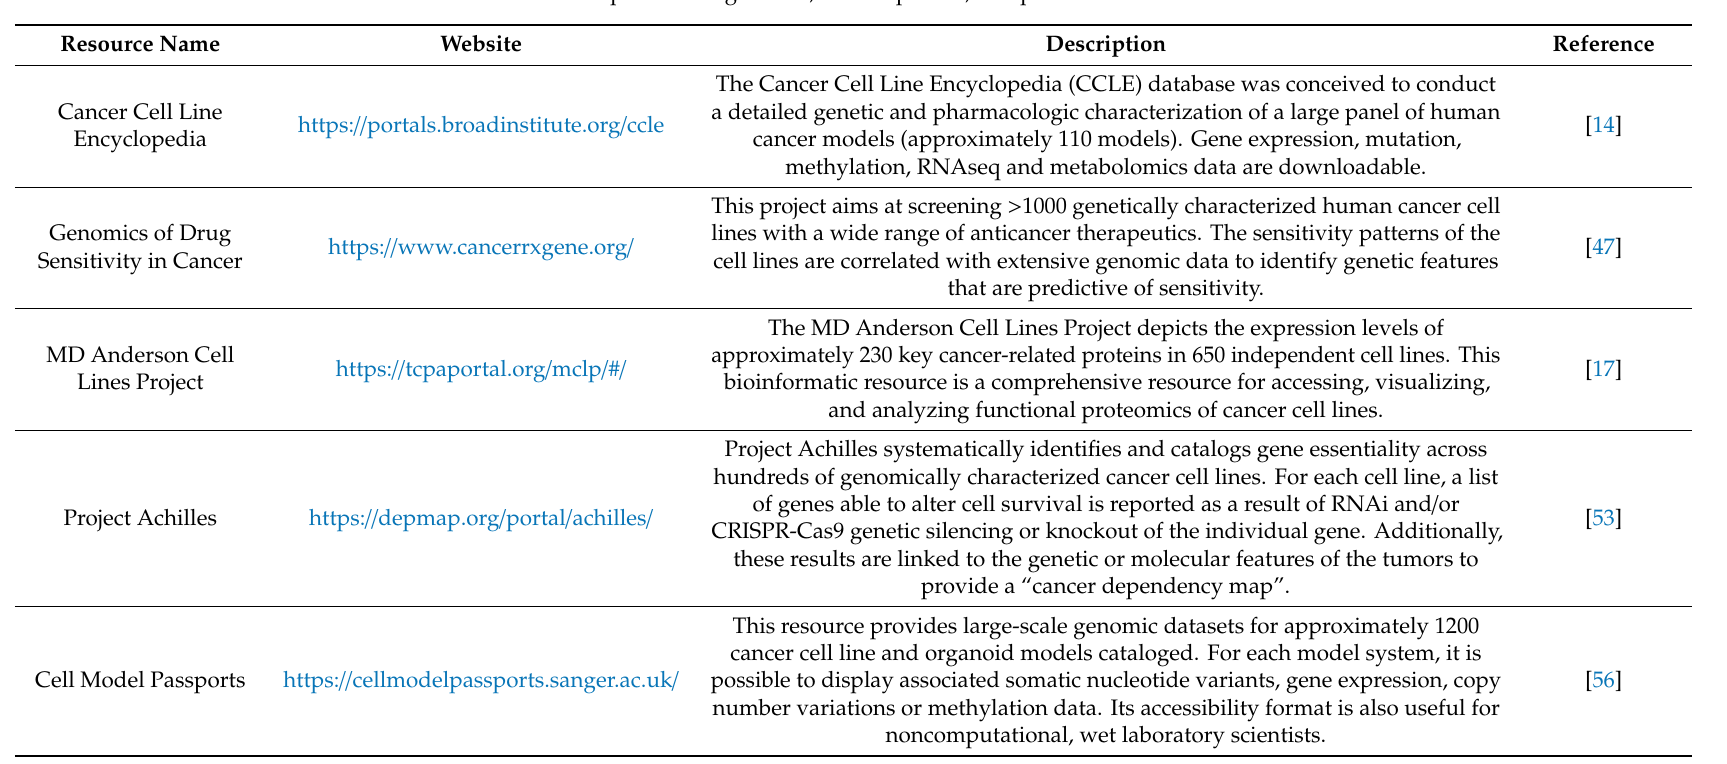
Table 2. List of online resources with comprehensive genomic, transcriptomic, and proteomic datasets derived from cancer cell